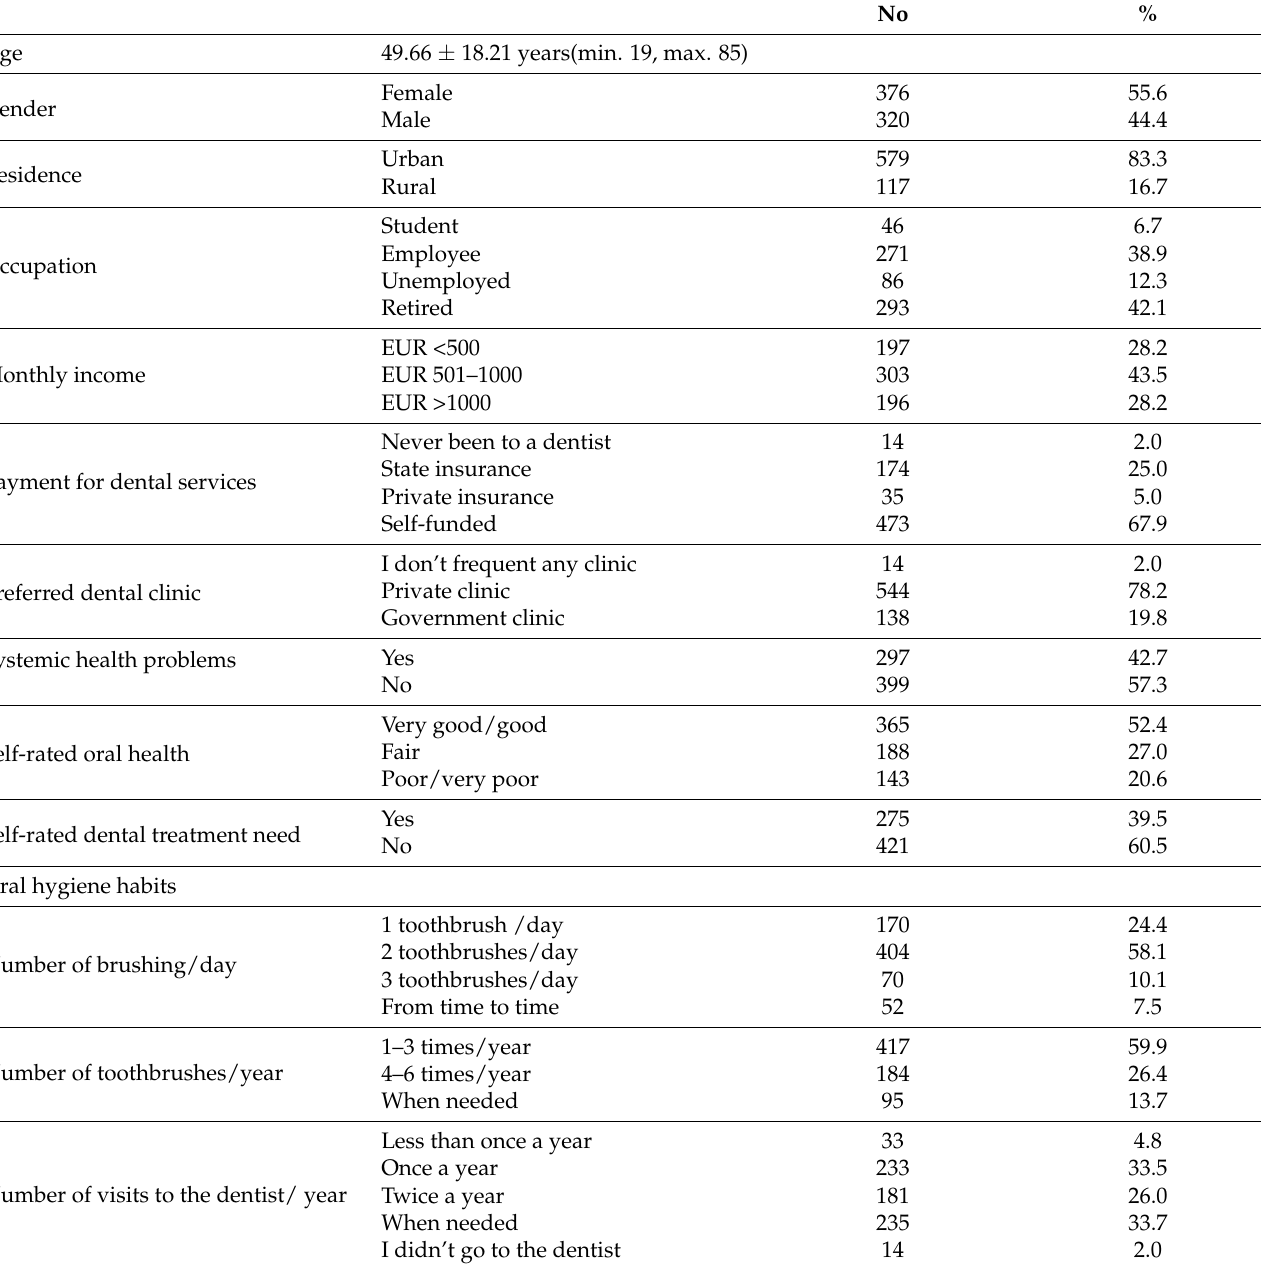
Table 1. Distribution (%) of subjects according to sociodemographic, general, and oral-health-related variables (N =